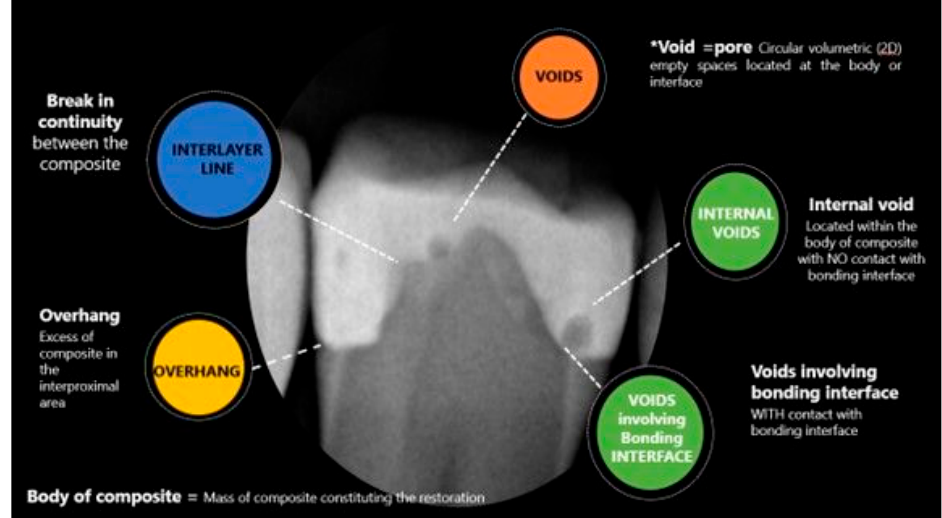
Figure 2. Illustrative scheme of the classification criteria for radiographic findings in class II composite restorations.